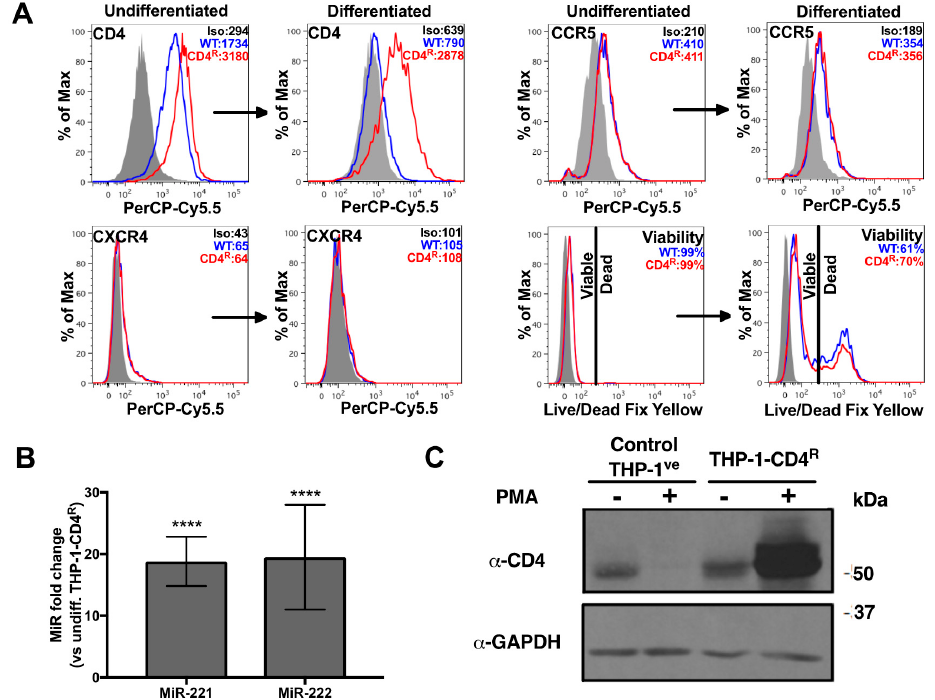
Figure 4. THP-1-CD4 R cells express CD4 independently of miR-221 and miR-222 modulation . **** p < 0.0001. ( A ) Either undifferentiated or PMA-differentiated THP-1-CD4 R cells (or the control THP-1 ve cells, WT) were analyzed for their viability and the surface levels of CD4, CXCR4 or CCR5 by cytofluorometry. Representative graphs are shown. Mean geometric fluorescence intensities (MFIs) or viability values are shown in the histograms. ( B ) The expression of miR-221 or miR-222 was compared in THP-1-CD4 R cells prior or after differentiation ( n = 12; means ± SD are shown and compared using Student’s t test). ( C ) Expression of CD4 was measured by western blot in either control THP-1 ve or THP-1-CD4 R cells, prior or following PMA-induced differentiation. A representative blot is shown.